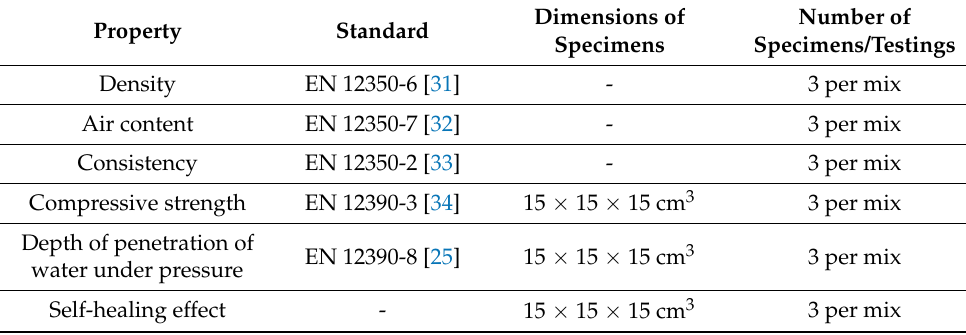
Table 3. Test methods for fresh and hardened concrete properties.